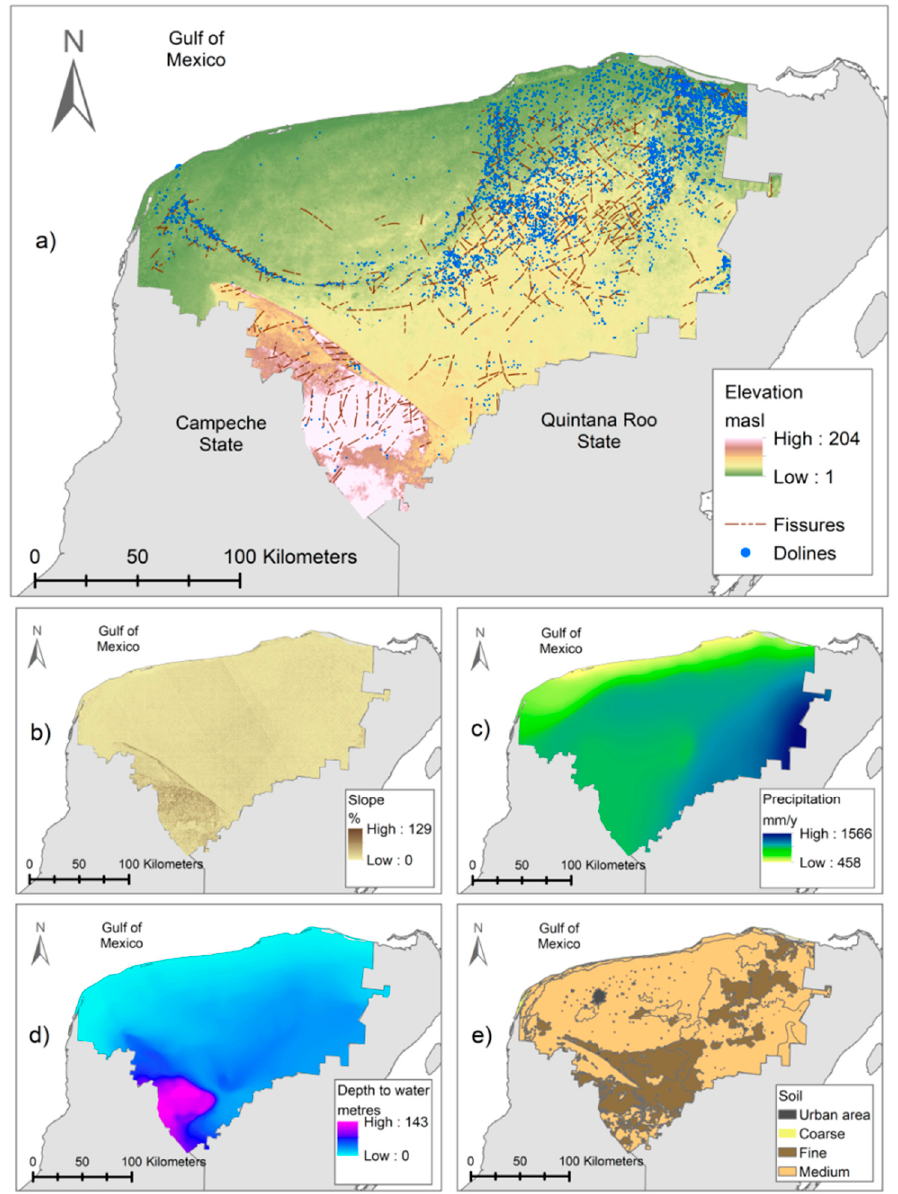
Figure 3. Maps representing the most characteristic features in Yucatan. ( a ) Elevation and karst features; ( b ) Slope; ( c ) Precipitation; ( d ) Depth to the water table and ( e ) Soil texture distribution.